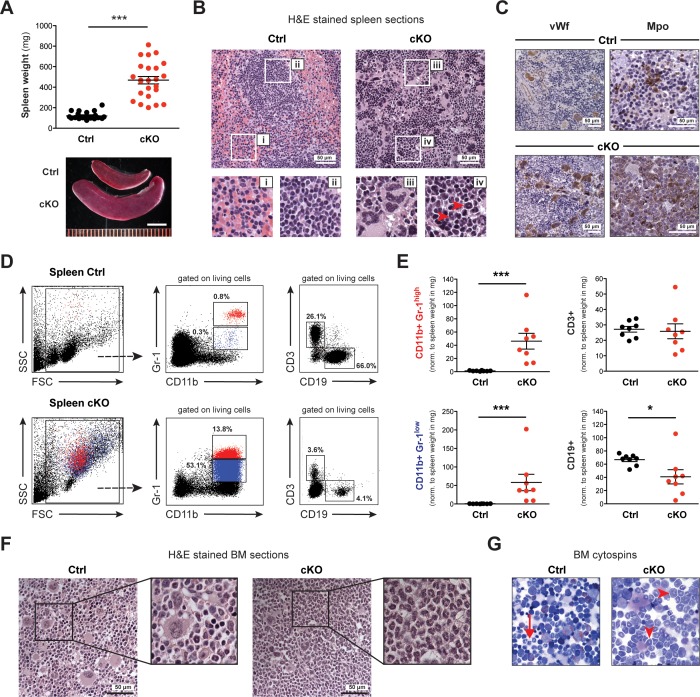
Spleen and BM of cKO mice show extensive accumulation of myeloid cells.(A) The spleens of cKO mice between 10 and 25 weeks after induction were on average fivefold heavier compared to age-matched controls (both n = 24) (p***<0.0001). Scale bar = 5 mm. The data is representative of 12 independent tamoxifen inductions. (B) H&E staining of spleen sections. Representative areas are outlined in white boxes and enlarged below: red (i) and white pulp (ii) in control spleens, megakaryocyte-like (iii) and myeloid cells (iv) with ring-shaped nuclei (red arrowheads) in cKO spleens. (C) Immunohistochemical staining of spleen sections with antibodies against von Willebrand factor (vWf) and myeloperoxidase (Mpo). Both vWf+ megakaryocytes and Mpo+ myeloid cells were major cell types in cKO spleens. (D) FACS analysis of splenic cell compartments. In cKO spleens, enriched CD11b+ Gr-1high (depicted in red) and CD11b+ Gr-1low (depicted in blue) myeloid cells as well as reduced CD3+ T cells and CD19+ B cells were detected. The given percentages are relative to living cells. (E) Quantification of FACS data normalized to spleen weight (mg) 7–25 weeks after induction (Ctrl n = 8, cKO n = 8). Both mature (Gr-1high) and immature (Gr-1low) myeloid cells were increased (p***<0.001), while B cells (p*=0.015) but not T cells were reduced in cKO tissue. The data is representative of six independent experiments. (F) H&E staining of femoral bone sections. In contrast to controls, cKO bone marrow (BM) revealed an excess of myeloid cells. (G) May-Grünwald-Giemsa staining of BM cytospin preparations. While in controls fully differentiated granulocytes were readily identified (arrow), cKO cytospins were characterized by a higher proportion of myeloid precursors (arrowheads). The graphs in (A) and (E) depict the mean ± SEM. (FSC = forward scatter, SSC = side scatter, norm. = normalized).